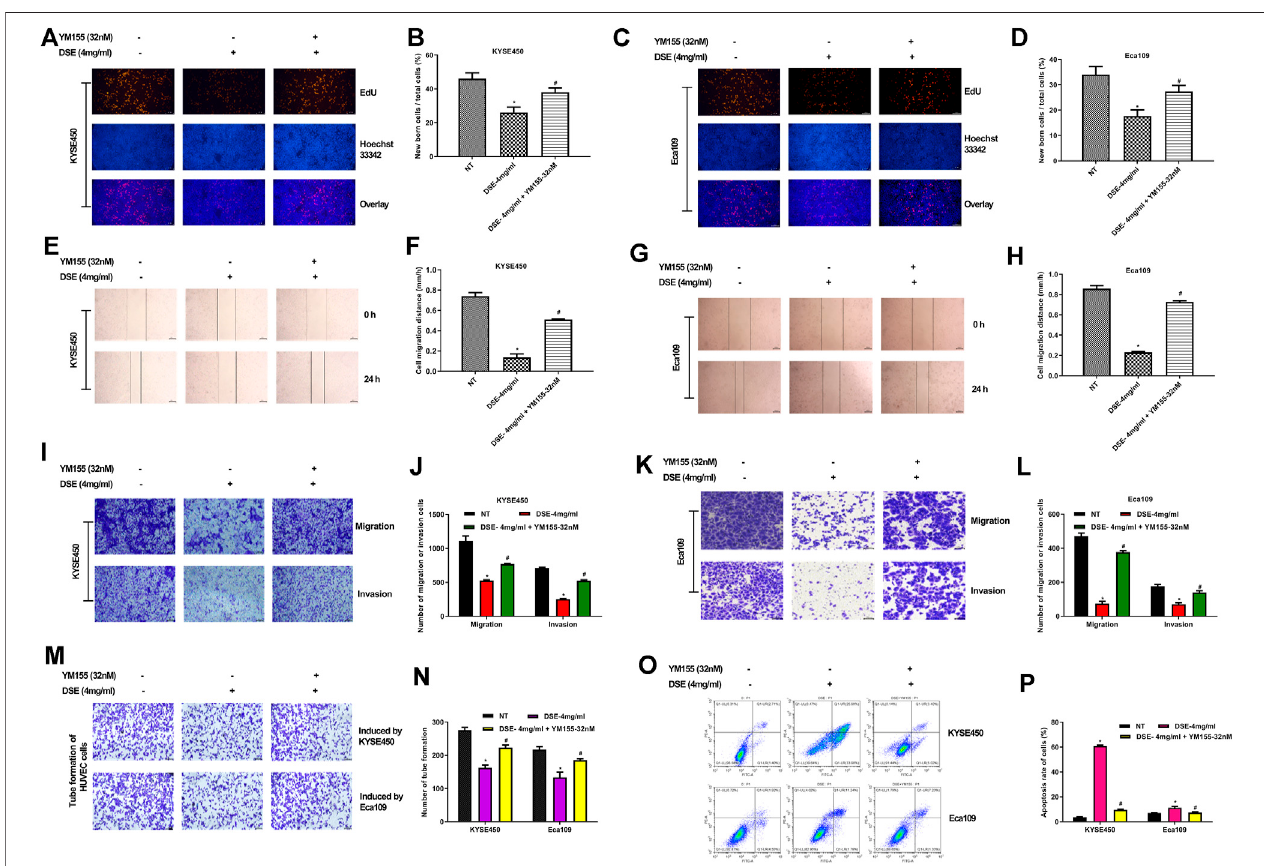
FIGURE7| SurvivininhibitorYM155impairstheabilitiesofDSEinESCCcells. (A – D) EffectsofsurvivininhibitorYM155onproliferationinhibitioninducedbyDSEin KYSE450 and Eca109 cells. Representative images were taken. Scale bars, 100 µm. (E – H) Effectsof survivin inhibitor YM155 on migration inhibition induced by DSE in KYSE450andEca109cells.Representativeimagesweretaken.Scalebars,500 µm. (I – L) EffectsofsurvivininhibitorYM155onmigrationandinvasioninhibitioninduced byDSEinKYSE450andEca109cells.Representativeimagesweretaken.Scalebars,100 µm. (M,N) EffectsofsurvivininhibitorYM155onangiogenesisinhibition induced by DSE in KYSE450 and Eca109 cells. Representative images were taken. Scale bars, 100 µm. (O,P) Effects of survivin inhibitor YM155 on apoptosis induced by DSE in KYSE450 and Eca109 cells. All data are expressed as mean ± standard deviation ( n =3).* p < 0.05 vs. NTgroup. # p < 0.05 vs. DSE group. NT: No treatment.